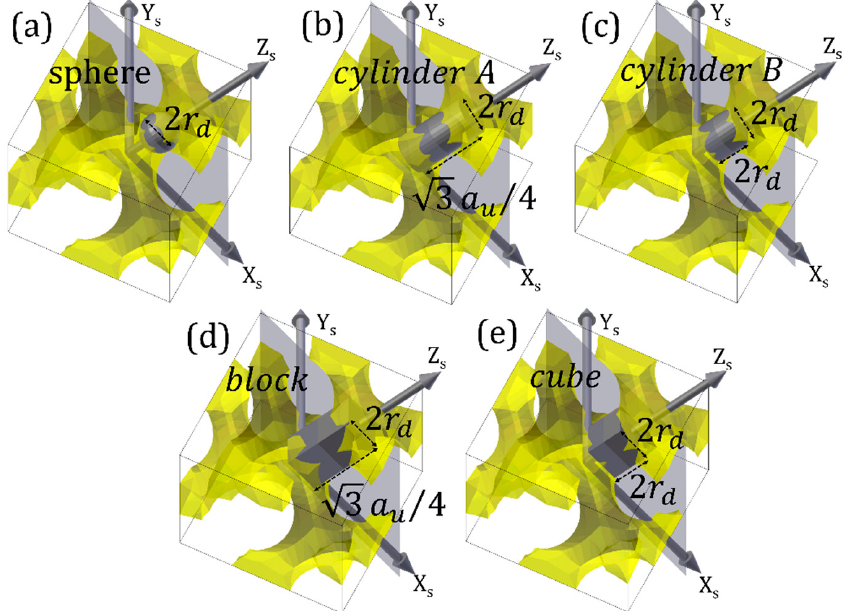
Figure 4. Five types of defect shapes including ( a ) a sphere of diameter D = 2 r d , ( b ) a cylinder (“cylinder A”) of diameter D = 2 r d and height L = 3 a u /4, ( c ) a cylinder (“cylinder B”) of diameter D = 2 r d and height of L cylB = 2 r d , ( d ) a rectangular block with a square base of side length W = 2 r d and a height of L = 3 a u /4, ( e ) a cube of side length W cube = L cube = 2 r d . The size of the defects varied from r d = 0.1 a u to 0.15 a u in 0.0125 a u steps and 0.15 a u to 0.5 a u in 0.025 a u steps. Here, the studied low-index-filled cavities ( n def = 1.0) are placed in the optimized location, S 2 . 0 [19], within the crystal along the Γ - L or Z s [1,1,1]